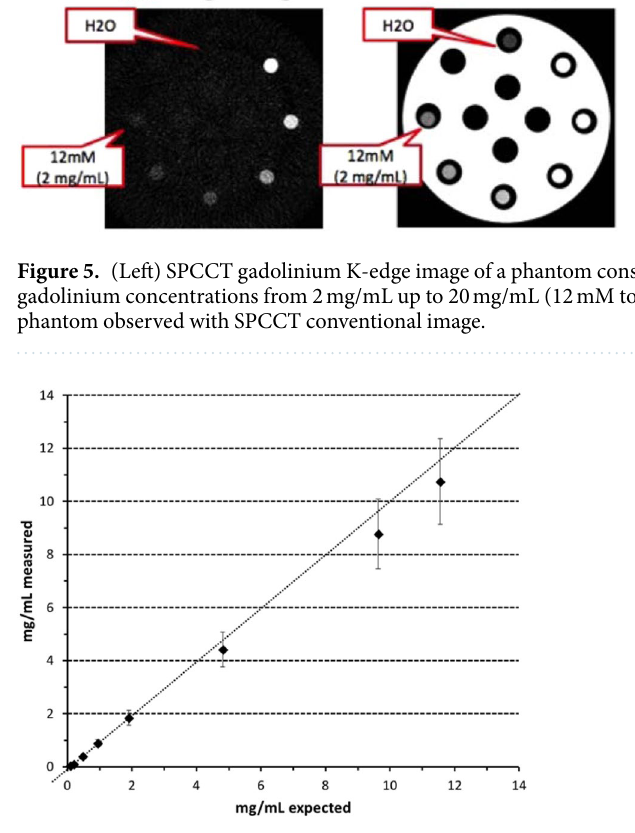
Figure 6. Correlation between measured concentration of gadolinium with K-edge and expected concentrations of the corresponding solutions determined by ICP.